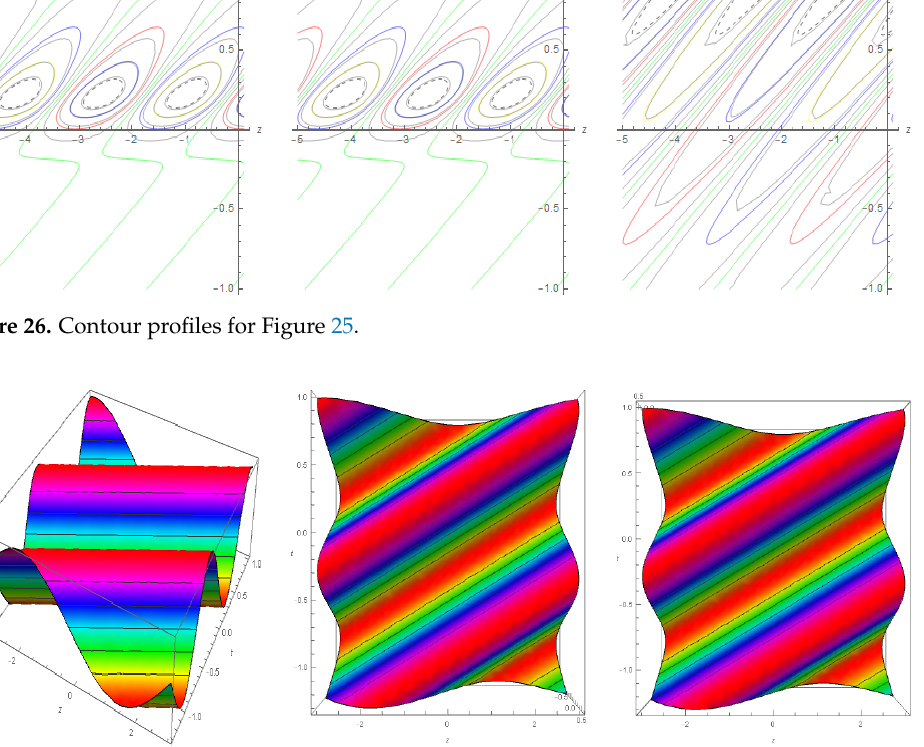
Figure 27. The PCR graphs of the solution ∆ 14 in Equation (52) are formed for particular values of b 2 = 1, a 4 = 2, a 2 = − 3, µ = 2, g 0 = 7, b 2 = 1, c 1 = 3, k 1 = 0.1, c 2 = 6 and γ = 2, k 2 = 1. Three-dimensional graphs at (i) a 1 = − 4, (ii) a 1 = 0 and (iii) a 1 = 30.